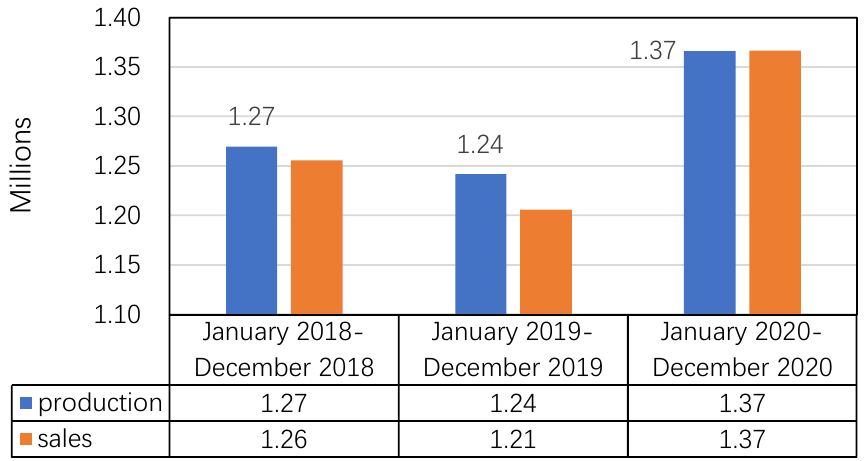
Figure 2. Comparison of production and sales volume of new energy vehicles in China in recent three years.